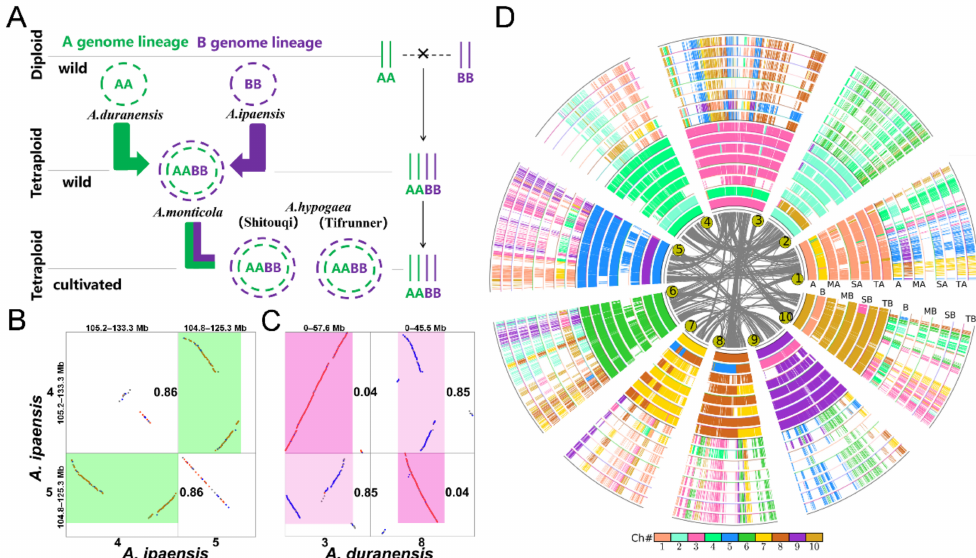
Figure 2. The phylogeny of the studied peanut genomes and inference of duplicated and orthologous gene pairs within and between genomes. ( A ) The phylogeny of the studied peanut genomes. ( B ) The genomic homologous dotplot within the A. ipaensis genome. Highlighted boxes indicate the paralogous blocks generated from the LCT event. The median Ks values of anchored gene pairs located in blocks are placed next to the highlighted boxes. ( C ) The genomic homologous dotplot between the genomes of A. ipaensis and A. duranensis . Highlighted boxes indicate the orthologous blocks produced by the divergence of A. ipaensis from A. duranensis . The median Ks values of anchored gene pairs located in blocks is placed next to the highlighted boxes. ( D ) Alignment of the peanut and relative genomes with A. duranensis as reference. The innermost circle represents the 10 chromosomes of the Ad genome and the gray lines linked paralogous genes generated from LCT. Genomic paralogy, orthology and outparalogy information within and among eight (sub) genomes, with the name abbreviations of A. duranensis (A), A. ipaensis (B), A. monticola A (MA), A. monticola B (MB), A. hypogaea A (Shitouqi) (SA), A. hypogaea B (Shitouqi) (SB), A. hypogaea A (Tifrunner) (TA) and A. hypogaea B (Tifrunner) (TB), displayed in 16 circles. The short line forming the innermost A. duranensis chromosome circle represents predicted genes, which have one set of paralogous regions, forming another circle. Each of the two sets of A. duranensis paralogous chromosomal regions has one orthologous region in other Arachis